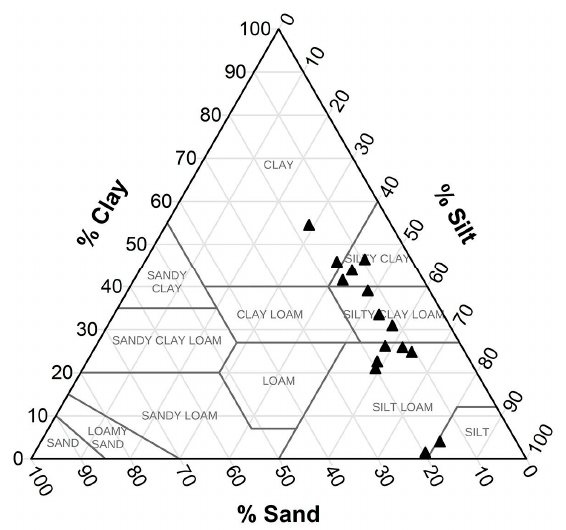
Figure 5. Sediment grain size distribution for ground control samples at the Alvord Hot Springs plume discharge site. Table 1. Total dissolved solids (TDS) and pH measurements of spring discharge in and around the plume. AHS081019-1 was collected from the plume center, Alvord Pool was collected from a val- ley-wall spring pool, and AHS2 was collected from spring discharge upslope from the pool.